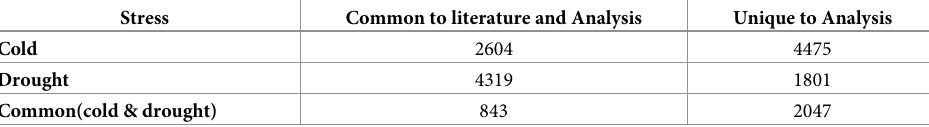
Table 1. Comparison of meta-analysis result with individual expression studies